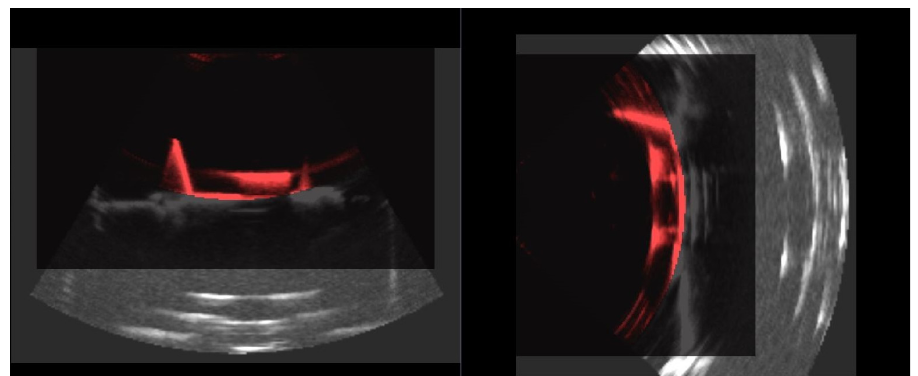
Fig 4. The 3D volume at 7.4 cm (red) is a sub-set of the volume with 15 cm scan depth (grey). They are registered to obtain the transform T 7.4 . Then the calibration matrix at 15 cm depth can be calculated. Thus, this cm ! 15 cm transformation is a simple translation.